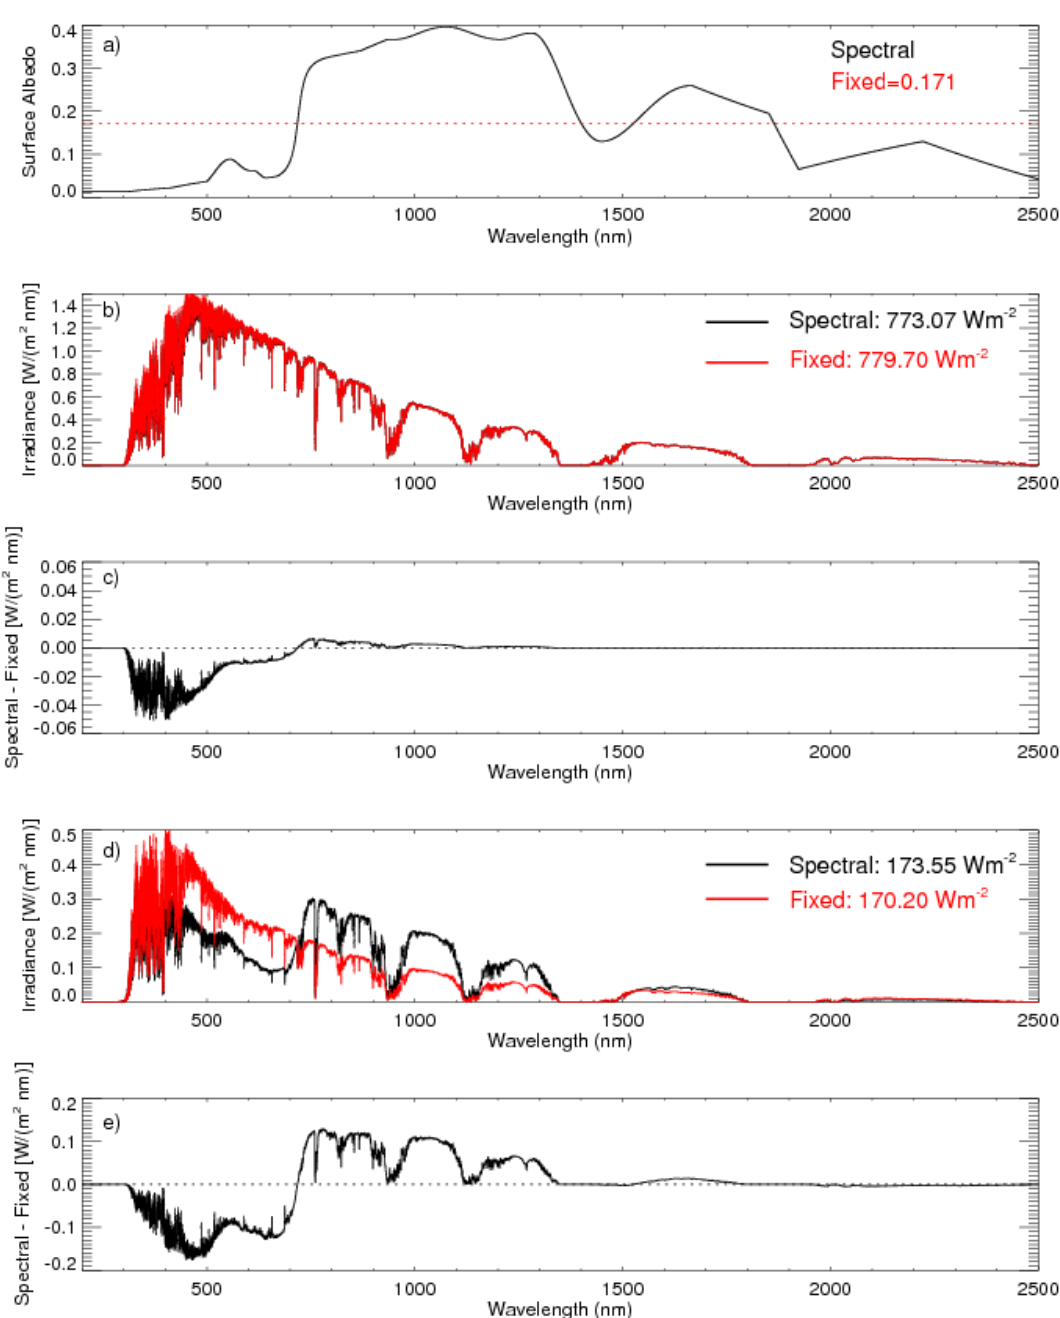
Fig. 12. Results of calculations using LBLRTM/CHARTS with spectrally varying and fixed albedo for the 4 May 2000 case. Panels show (a) spectrally varying and fixed albedo used in calculations, (b) calculated downwelling irradiance at the surface, (c) irradiance difference (spectral – fixed albedo) at the surface, (d) calculated upwelling irradiance at the top of the atmosphere, and (e) irradiance difference (spectral fixed albedo) at the top of the atmosphere. The plot is limited to wavelength ranges from 300nm to 2500nm to emphasize the regions with largest irradiance differences, but the total irradiance across the shortwave spectrum (from 200 to 12000nm) for each calculation is given in the figure legends.